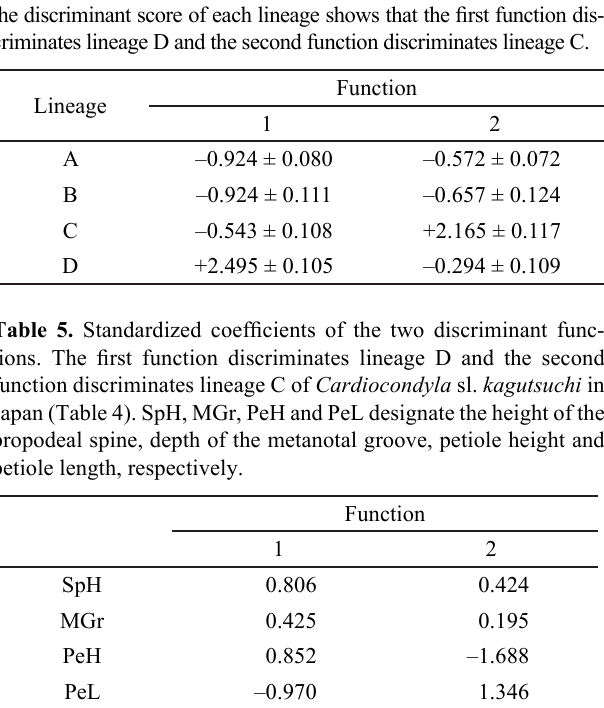
Table 4. Discriminant scores (mean ± SE) of each lineage (A, B, C and